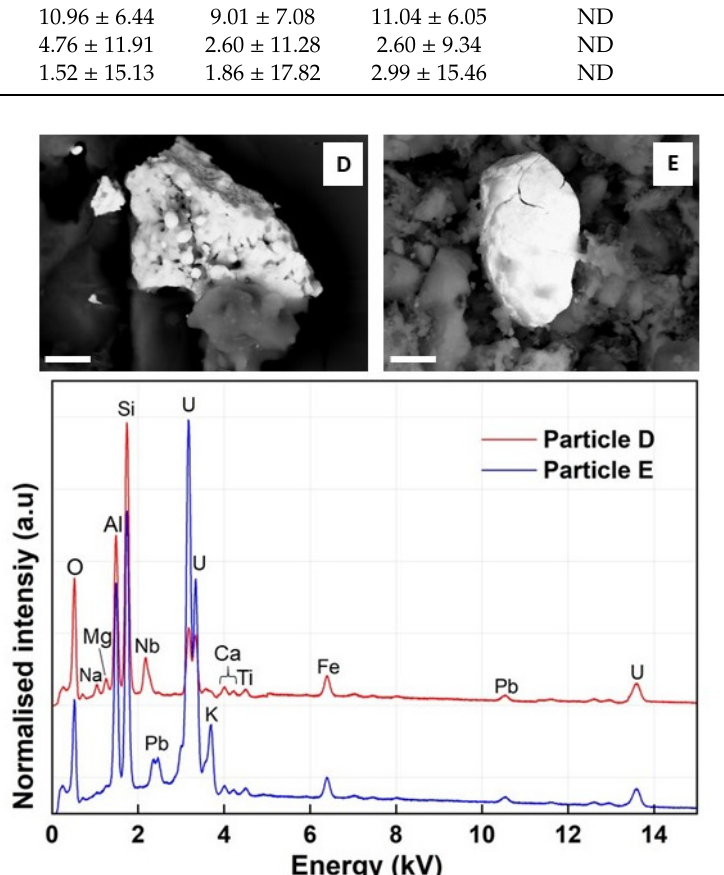
Figure 2. (Top) backscattered electron images of three monazite particles ( A and B in Okaba coal ash; C in Omelewu coal ash). (Bottom) associated EDS spectra with emission peaks identified (scale bars = 10 μ m).